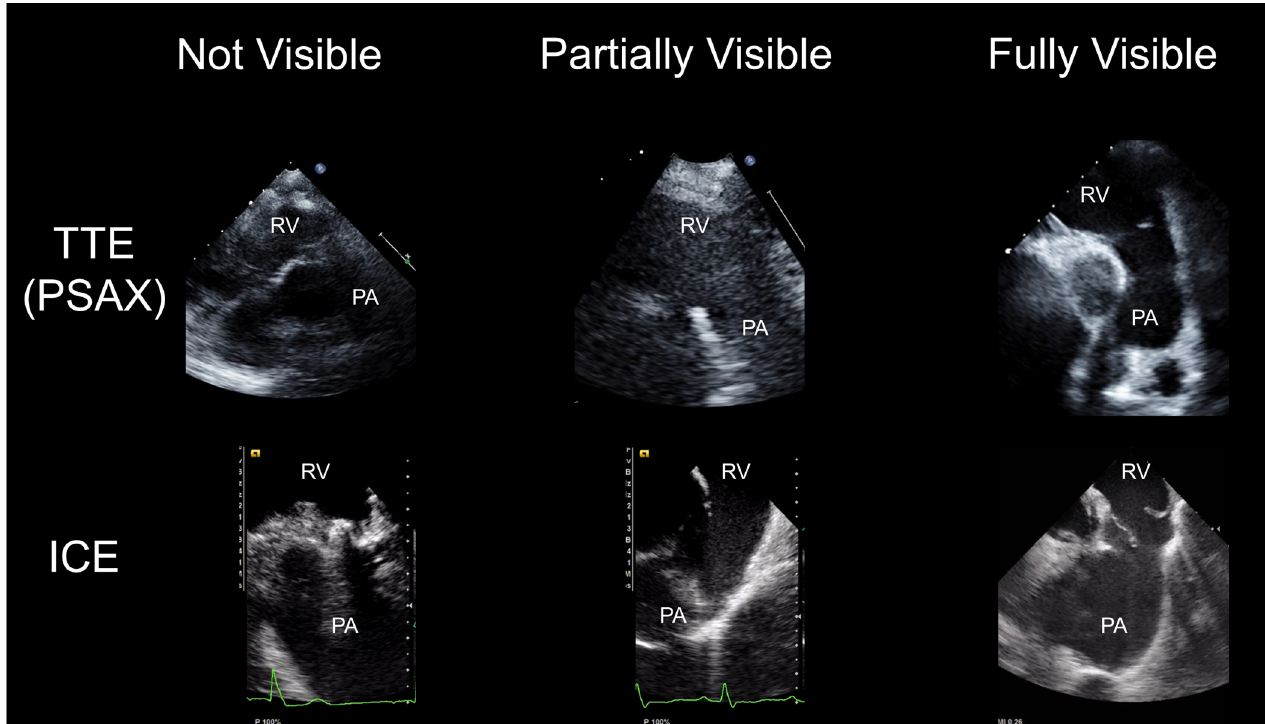
Figure 2. Echocardiographic assessment of PV using TTE and ICE. Representative imaging of the “not visible”, “partially visible” and “fully visible” classifications by TTE and ICE. The upper and lower images are not of the same patients. TTE, transthoracic echocardiography; ICE, intracardiac echocardiography; RV, right ventricle; PA, pulmonary artery; PSAX, parasternal short axis.